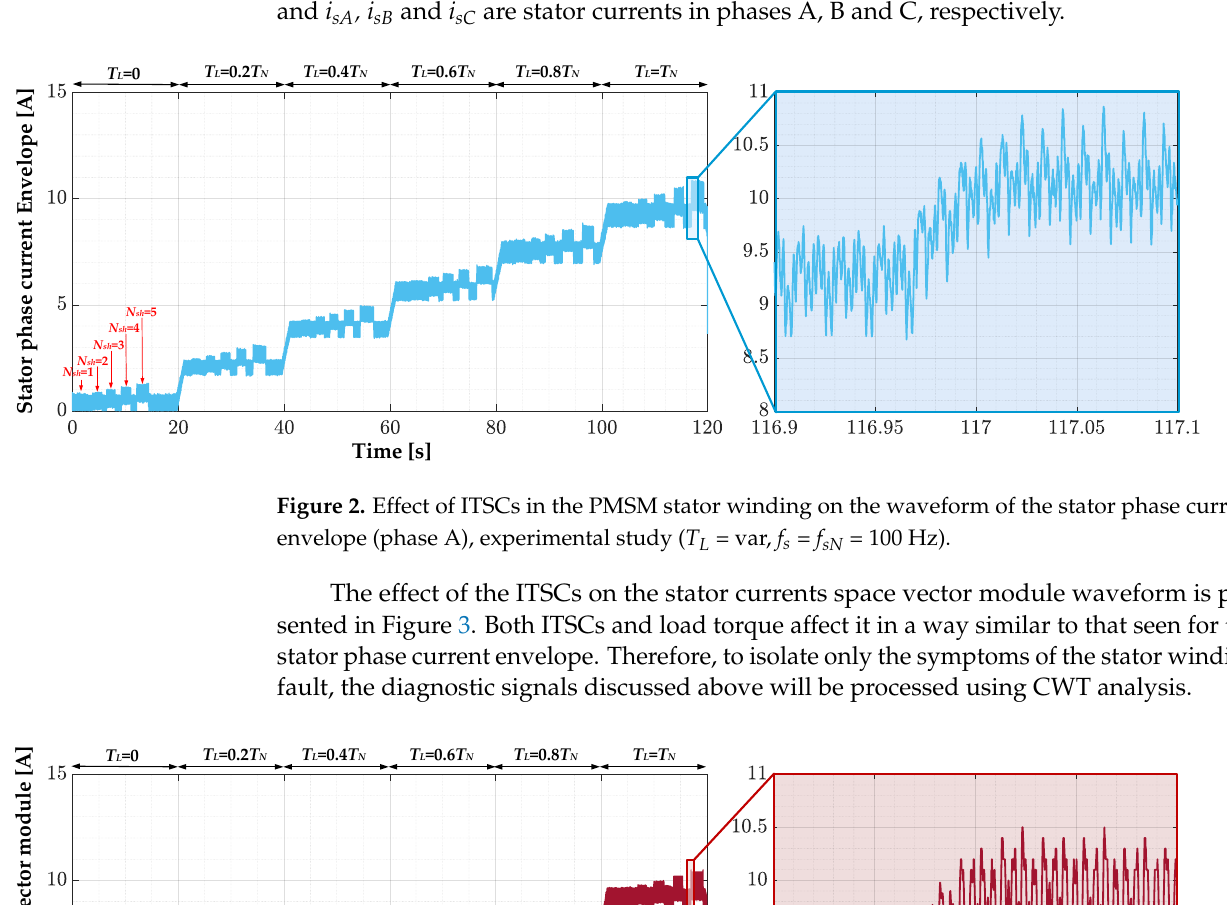
Figure 3. Effect of ITSCs in the PMSM stator winding on the waveform of the stator phase current space vector module, experimental study ( T L = var, f s = f sN = 100 Hz). 3. Continuous Wavelet Transform Theoretical Basis Methods that perform time–frequency analysis are used to describe the relationship between signal information in the time domain and its spectral distribution in the fre- quency domain [45]. This group of methods is particularly useful in the process of extract- ing symptoms of electric motor failures. CWT is one of the methods belonging to this group. The result of CWT contains both time and frequency information of the analyzed signal [46]. CWT has found application in the field of fault diagnosis in the past, but